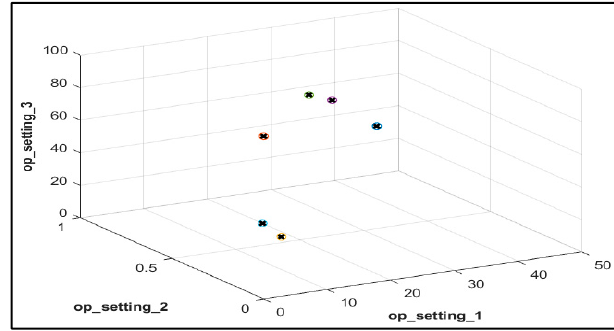
Figure 3. Operational regimes for three operational settings.